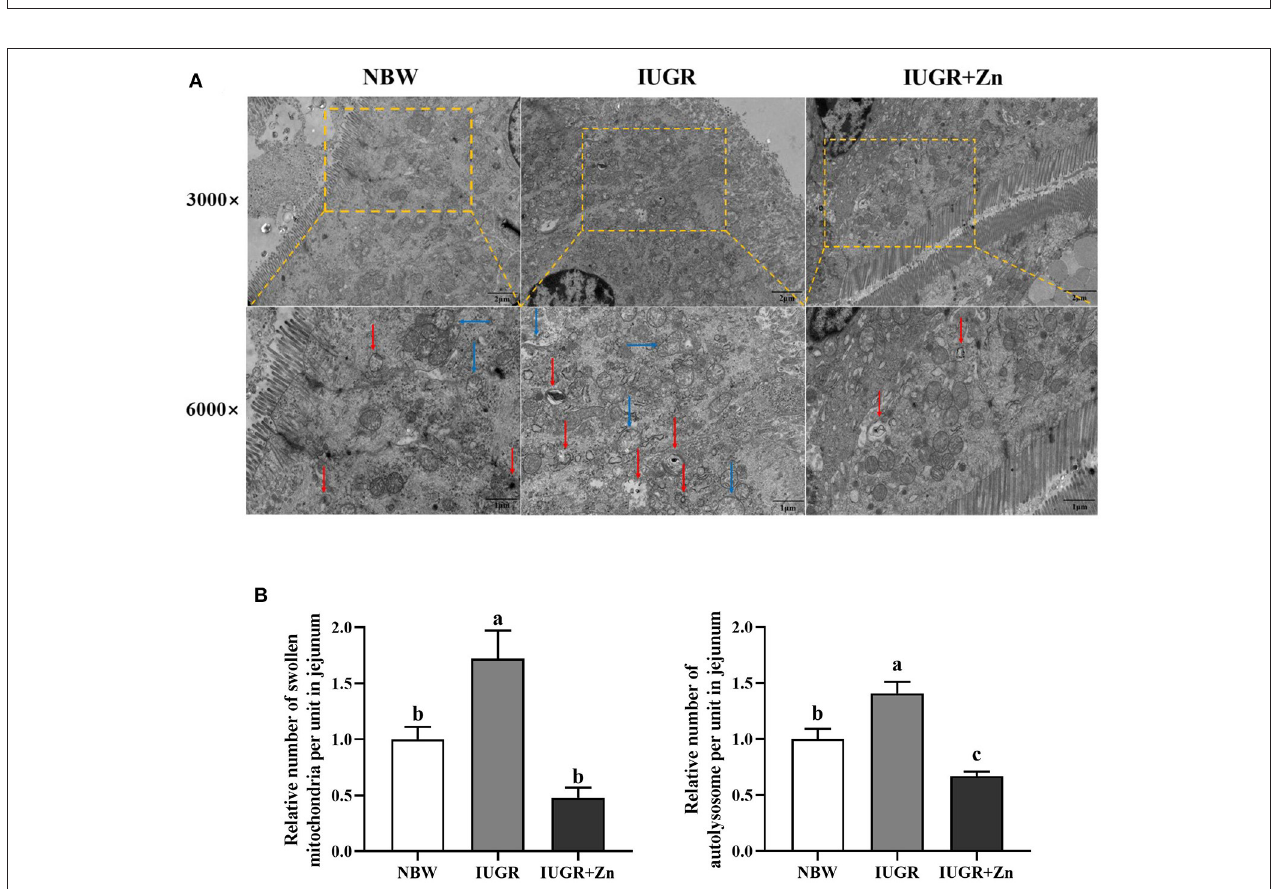
FIGURE 2 | Effects of dietary Nano-ZnO supplementation on the jejunal mitochondrial ultrastructure of IUGR finishing pigs. (A) Representative image of jejunum using transmission electron microscopy, red arrows indicated autolysosome, blue arrows indicated the swollen mitochondria. (B) Quantitative analysis of swollen mitochondria and autolysosome of pigs’ jejunal mucosa under transmission electron microscopy images (based on 3,000 times magnification, analysis of 4 images in each group, n = 4). Results were normalized by the mean value for the NBW group set to 1 unit. a,b Means for the same parameter with different superscripts are significantly different ( P < 0.05). NBW, normal birth weight pigs; IUGR, intrauterine growth restriction pigs; IUGR + Zn, IUGR pigs fed with diets supplemented with 600mg Zn/kg from Nano-ZnO.